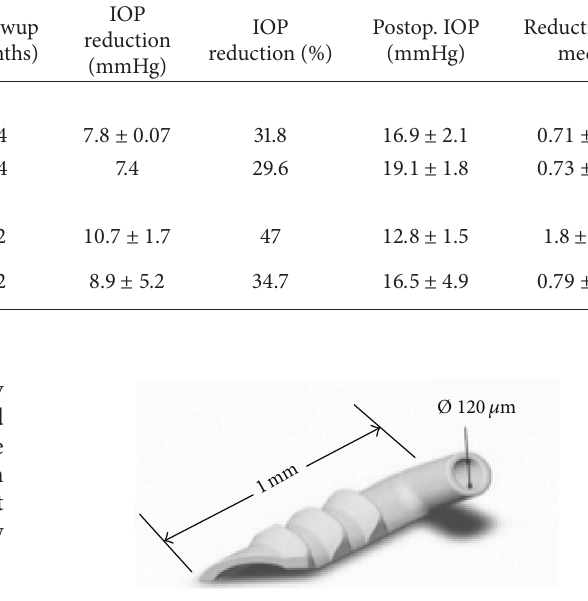
Figure 4: Gonioscopic view of implanted transtrabecular microby- pass (iStent) in situ (courtesy of Glaukos